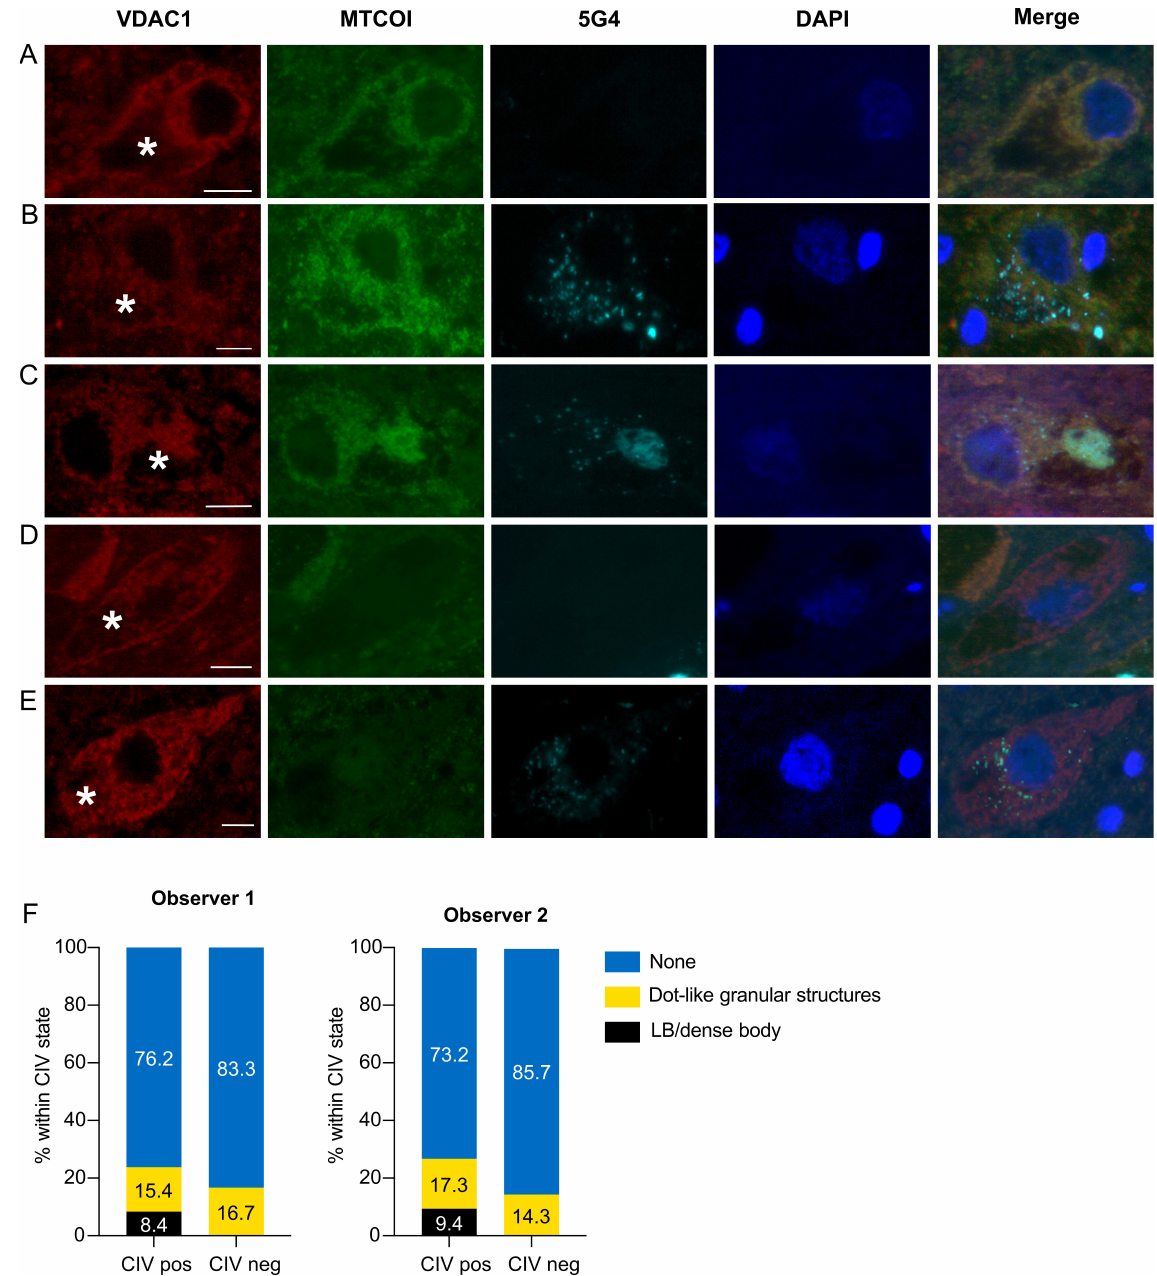
Figure 3. Immunofluorescence staining for CIV and aggregated α -synuclein in dopaminergic neurons of the SNc. Images show representative illustrations of fluorescence immunoreactivity against the mitochondrial outer membrane (VDAC1, red), CIV (MTCOI, green), aggregated α -syn (5G4, cyan), dsDNA (DAPI, blue), and a combination of all channels (merge). CIV-positive neurons were 5G4- negative ( A ), or positive with punctate inclusions ( B ) or LB/PB ( C ). CIV-negative neurons were either 5G4-negative ( D ), or positive with punctate inclusions ( E ). Neuromelanin is marked with an asterisk. Scale bar: 10 microns. The graphs in ( F ) depict the total percentage of neurons in each α -syn inclusion state (LB or PB/punctate inclusions/no inclusion) within each CIV state (positive/negative) from each of the